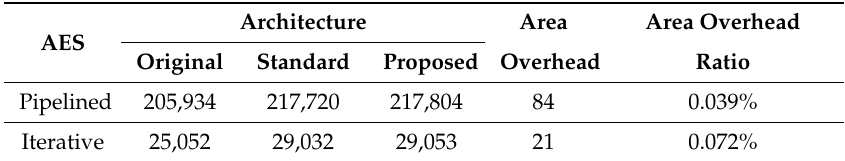
Table 3. Synthesis results of original implementation, standard scan design and proposed secure architecture.